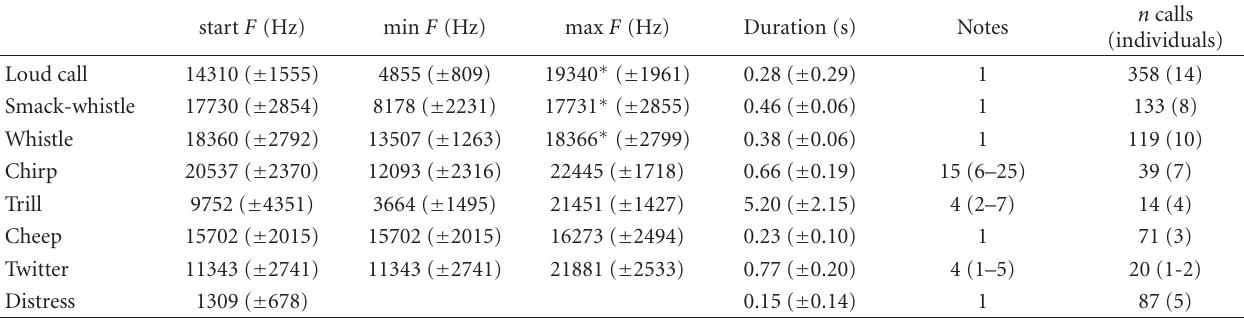
Table 1: Acoustic parameters of eight call types identified in the repertoire of the Philippine tarsier—start frequency (start F ) (mean ( ± SD)) (Hz), minimum frequency (min F ) (Hz), maximum frequency (max F ) (Hz), duration (s), and number of notes contained in the call— mean (min-max) ( ∗ max F reached above 22 kHz several times). It was di ffi cult to measure min F and max F in distress call; therefore, only start F (start of the fundamental frequency) and duration was measured. Numbers of analyzed calls (individuals) are given in each call